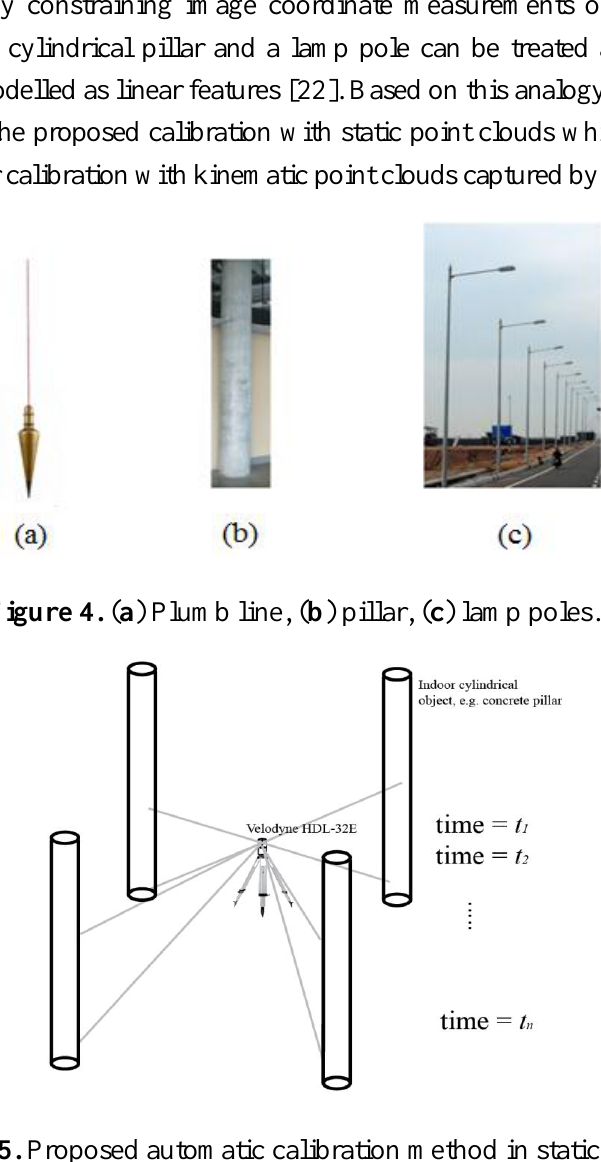
Figure 5. Proposed automatic calibration method in static